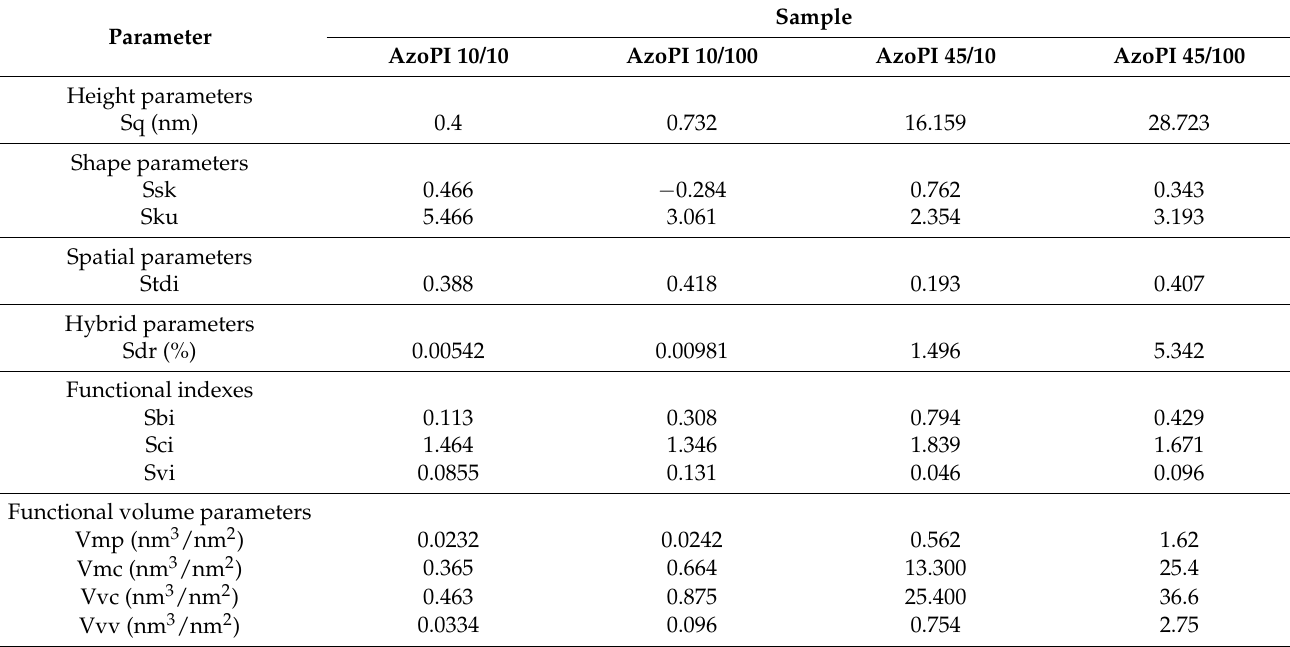
Table 1. 3D roughness parameters obtained from AFM images of the investigated azo-polyimide samples (energy density of 10 or 45 mJ/cm 2 and variable number of laser pulses 10